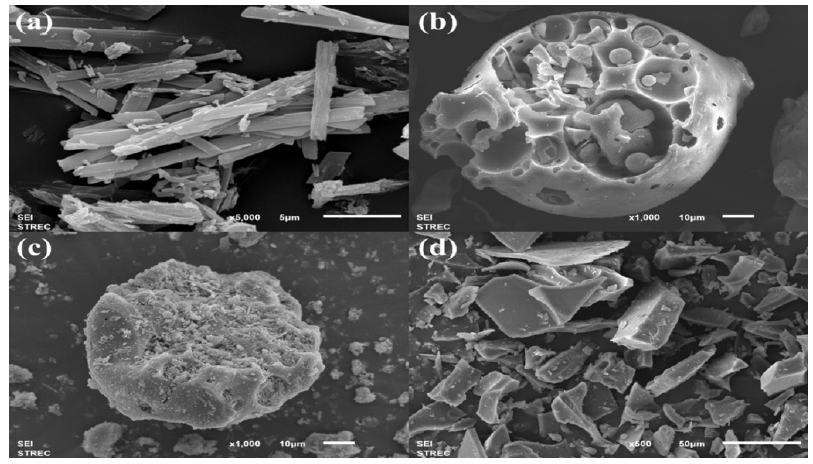
Figure 3. SEM images of ( a ) quercetin, ( b ) HP- β -CD, ( c ) quercetin/HP- β -CD physical mixture, and ( d ) quercetin/HP- β -CD inclusion complex.